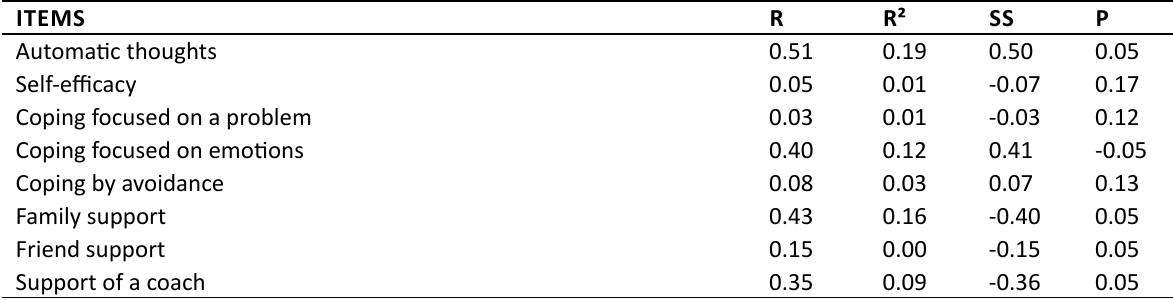
Table 5. Contribution of negative events to depression pReDIc